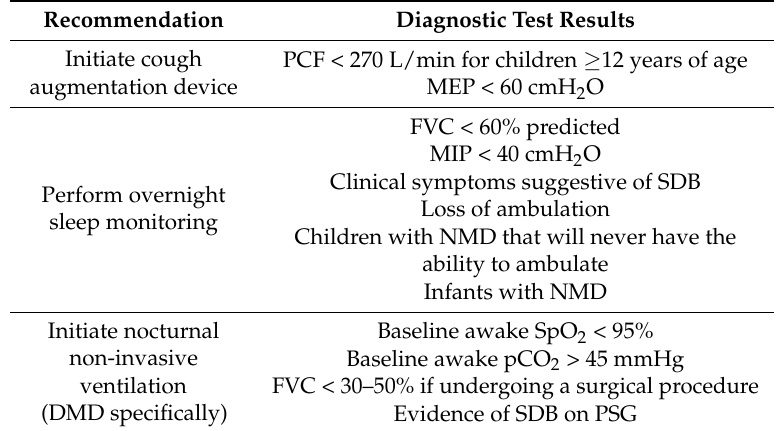
Table 2. Clinical management recommendations for children with neuromuscular disease (NMD) on the basis of diagnostic test